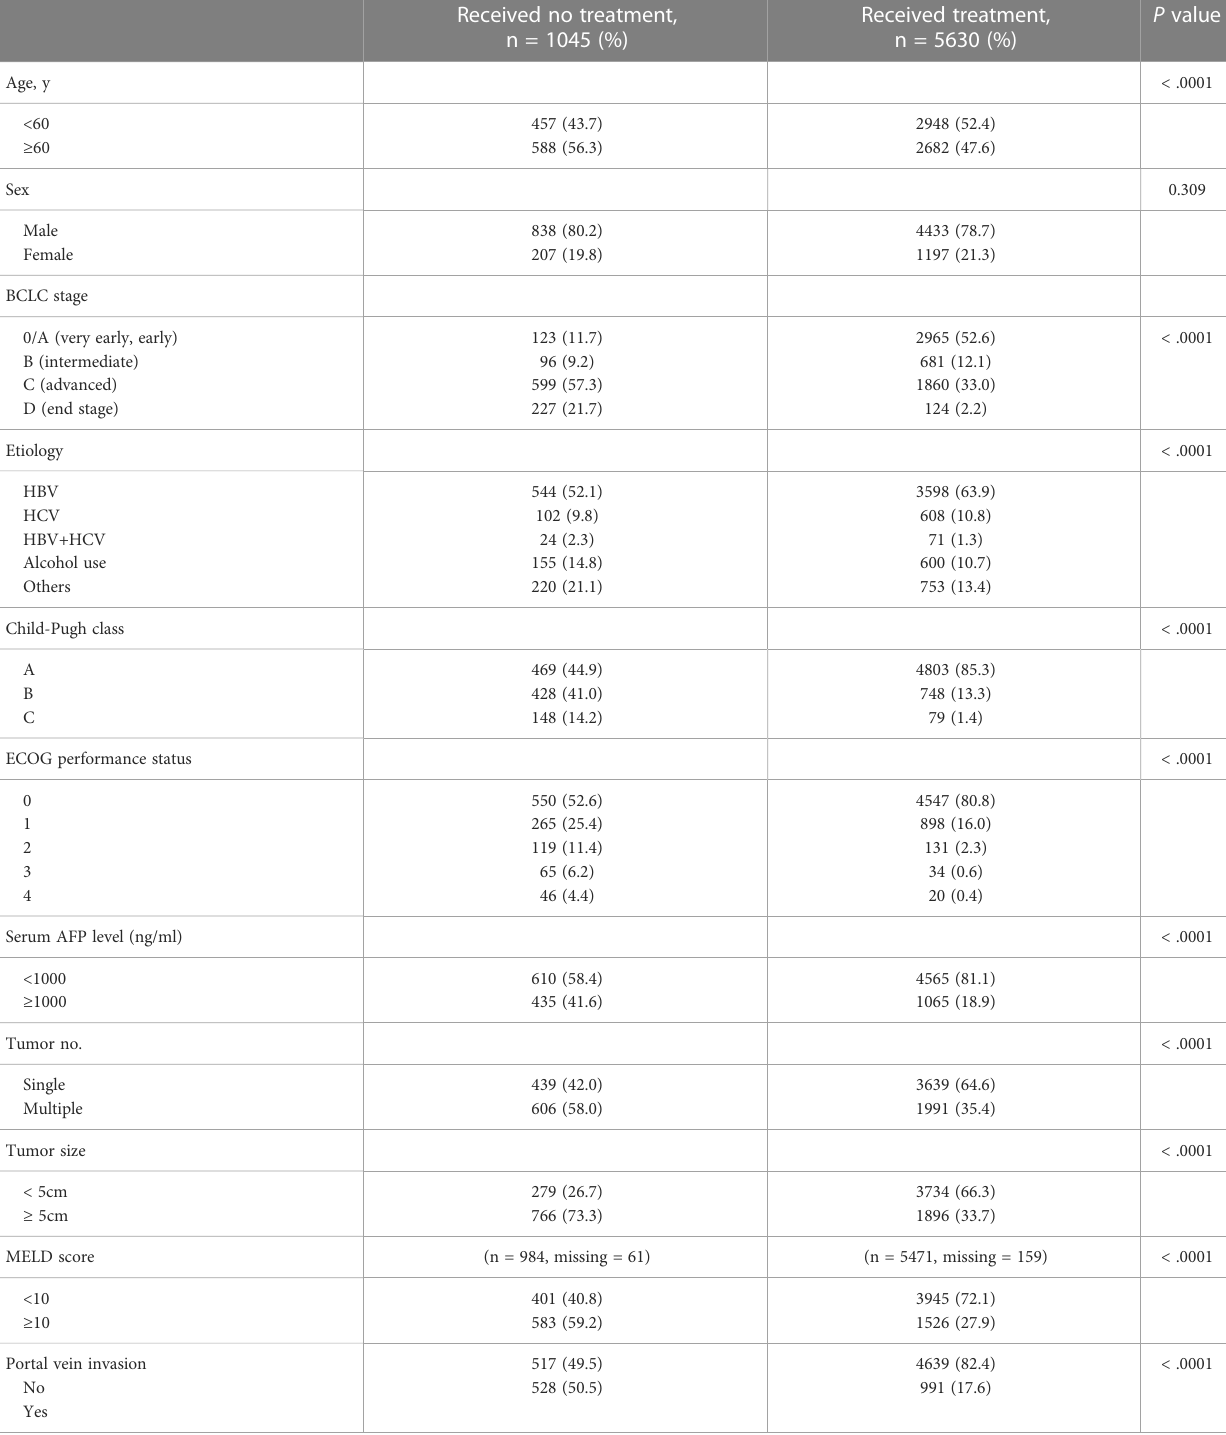
TABLE 1 Characteristics of HCC patients who received and did not receive any